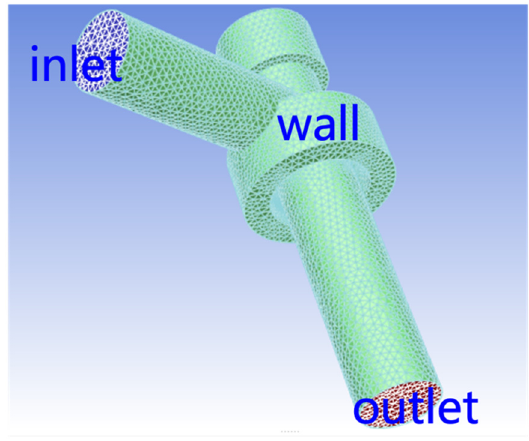
Figure 3. Fluid geometry and meshing.